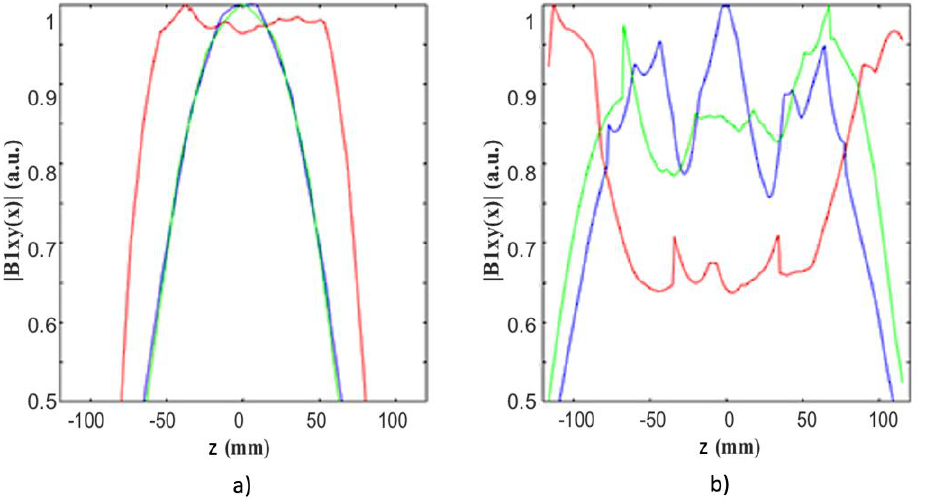
Figure 9 . Longitudinal | 𝑩 𝟏+ | profiles along the z -axis at the sodium ( a ), and proton ( b ), Larmor frequency of the 7 T four-ring DT-RF coil model for the ‘long’ (red line), ‘short’ (blue line) and ‘intermediate’ (green line) configurations .